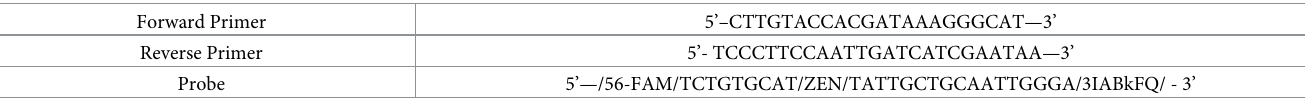
Table 1. Primer and probe sequences for the AGR